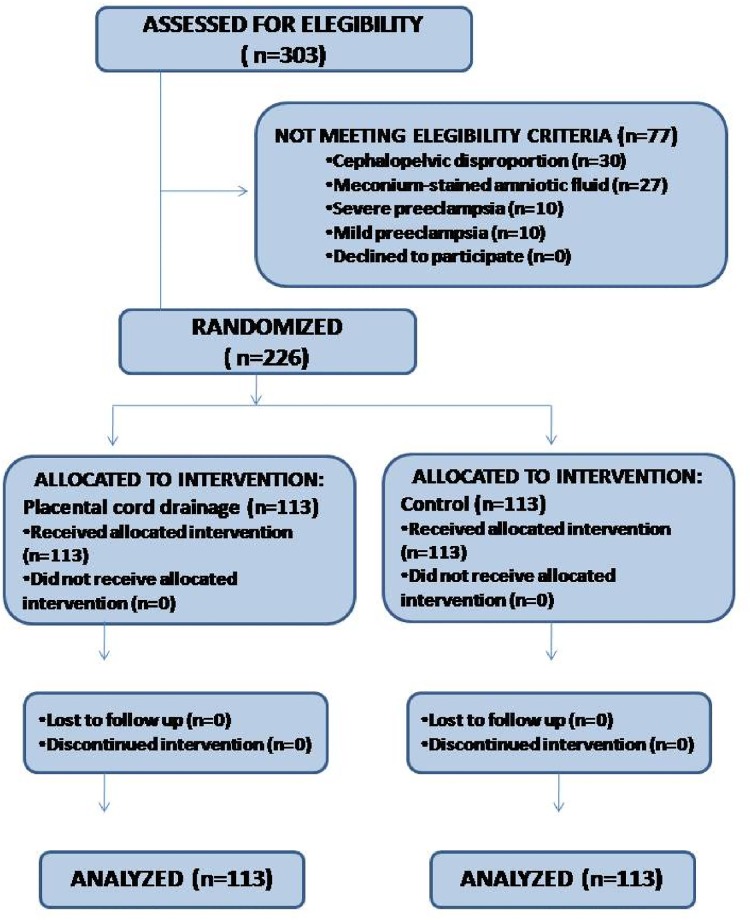
Study flowchart.